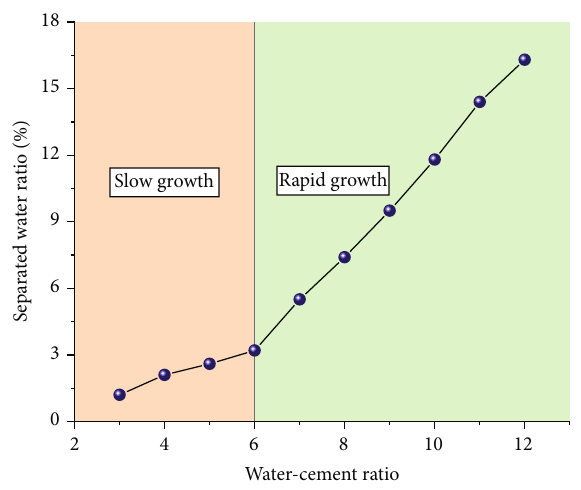
Figure 4: Relations between water retention rate of the slurry and water-cement